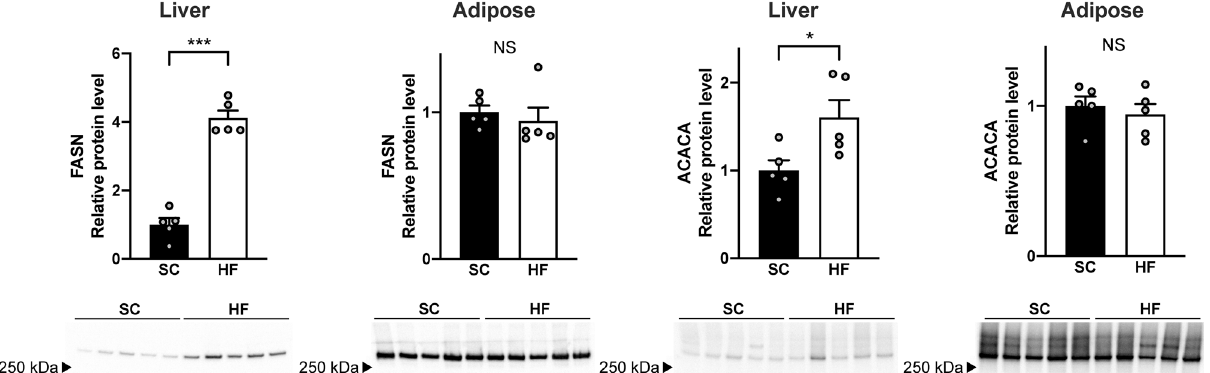
Figure 5. FASN and ACACA protein levels. High-fructose (HF) feeding leads to upregulation of FASN and ACACA protein in liver. Protein levels in adipose tissue were not significantly different between standard chow (SC) and HF groups. Protein levels were normalized to total protein measured in gels before transfer. Separate gels were used for “Liver FASN”, “Adipose FASN”, “Liver ACACA”, and “Adipose ACACA”. Uncut gels can be found in Supplementary information S1, Fig. 1. Significant differences between groups are indicated by * p < 0.05 and *** p < 0.001 (Student’s